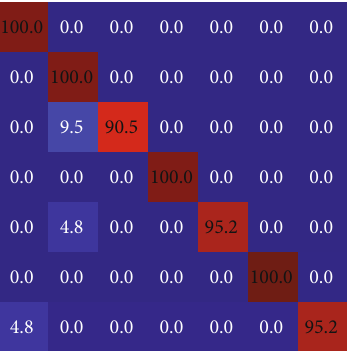
Figure 3: Confusion matrix of di ff erent aerobics sport